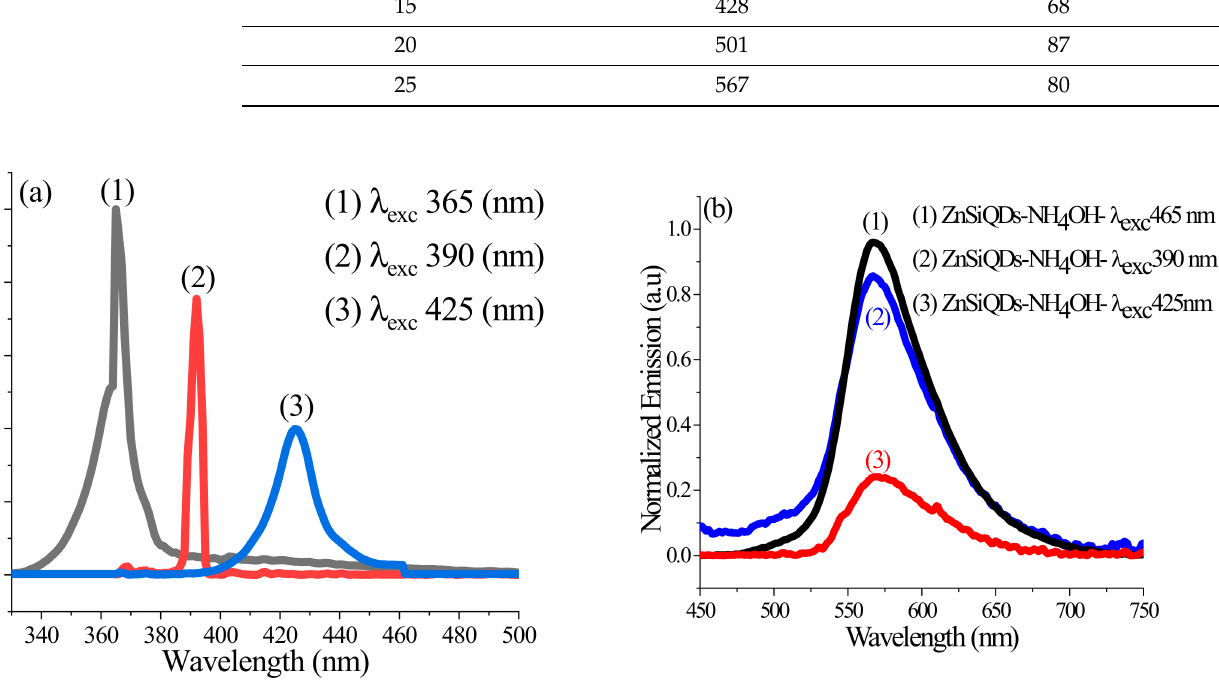
Figure 12. ( a ) Excitation spectra of source at excitation peak of (1) 365 nm, (2) 390 nm, and (3) 425 nm. ( b ) PL spectra of the colloidal ZnSiQD suspension in acetone containing 25 µ L of NH 4 OH excited at the wavelengths of (1) 365 nm, (2) 390 nm, and (3) 425